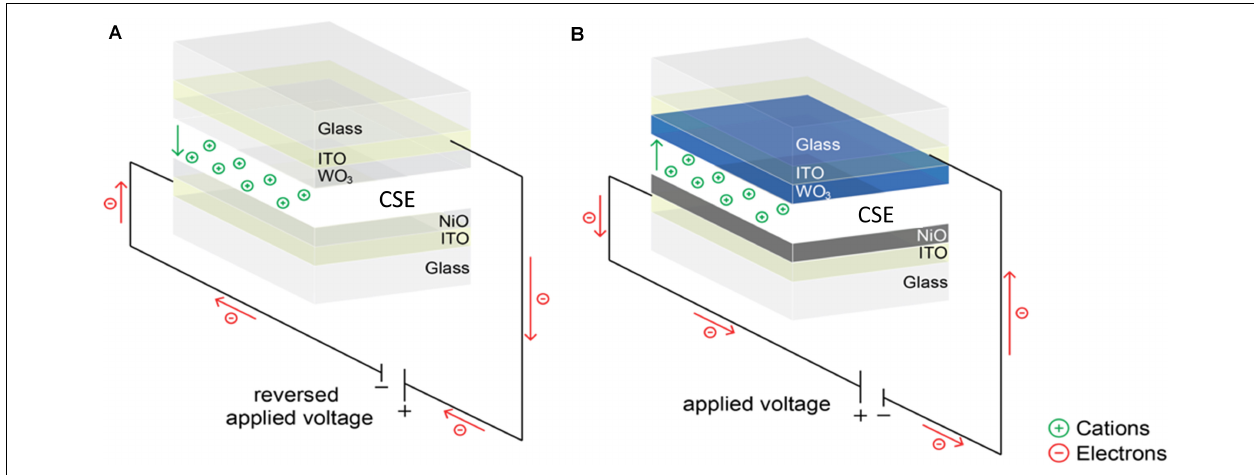
FIGURE 1 | Schematic representation of the electrochromic devices (ECD) produced (Glass/ITO/WO3/CSE/NiO/ITO/Glass) in the: (A) bleached and (B) colored